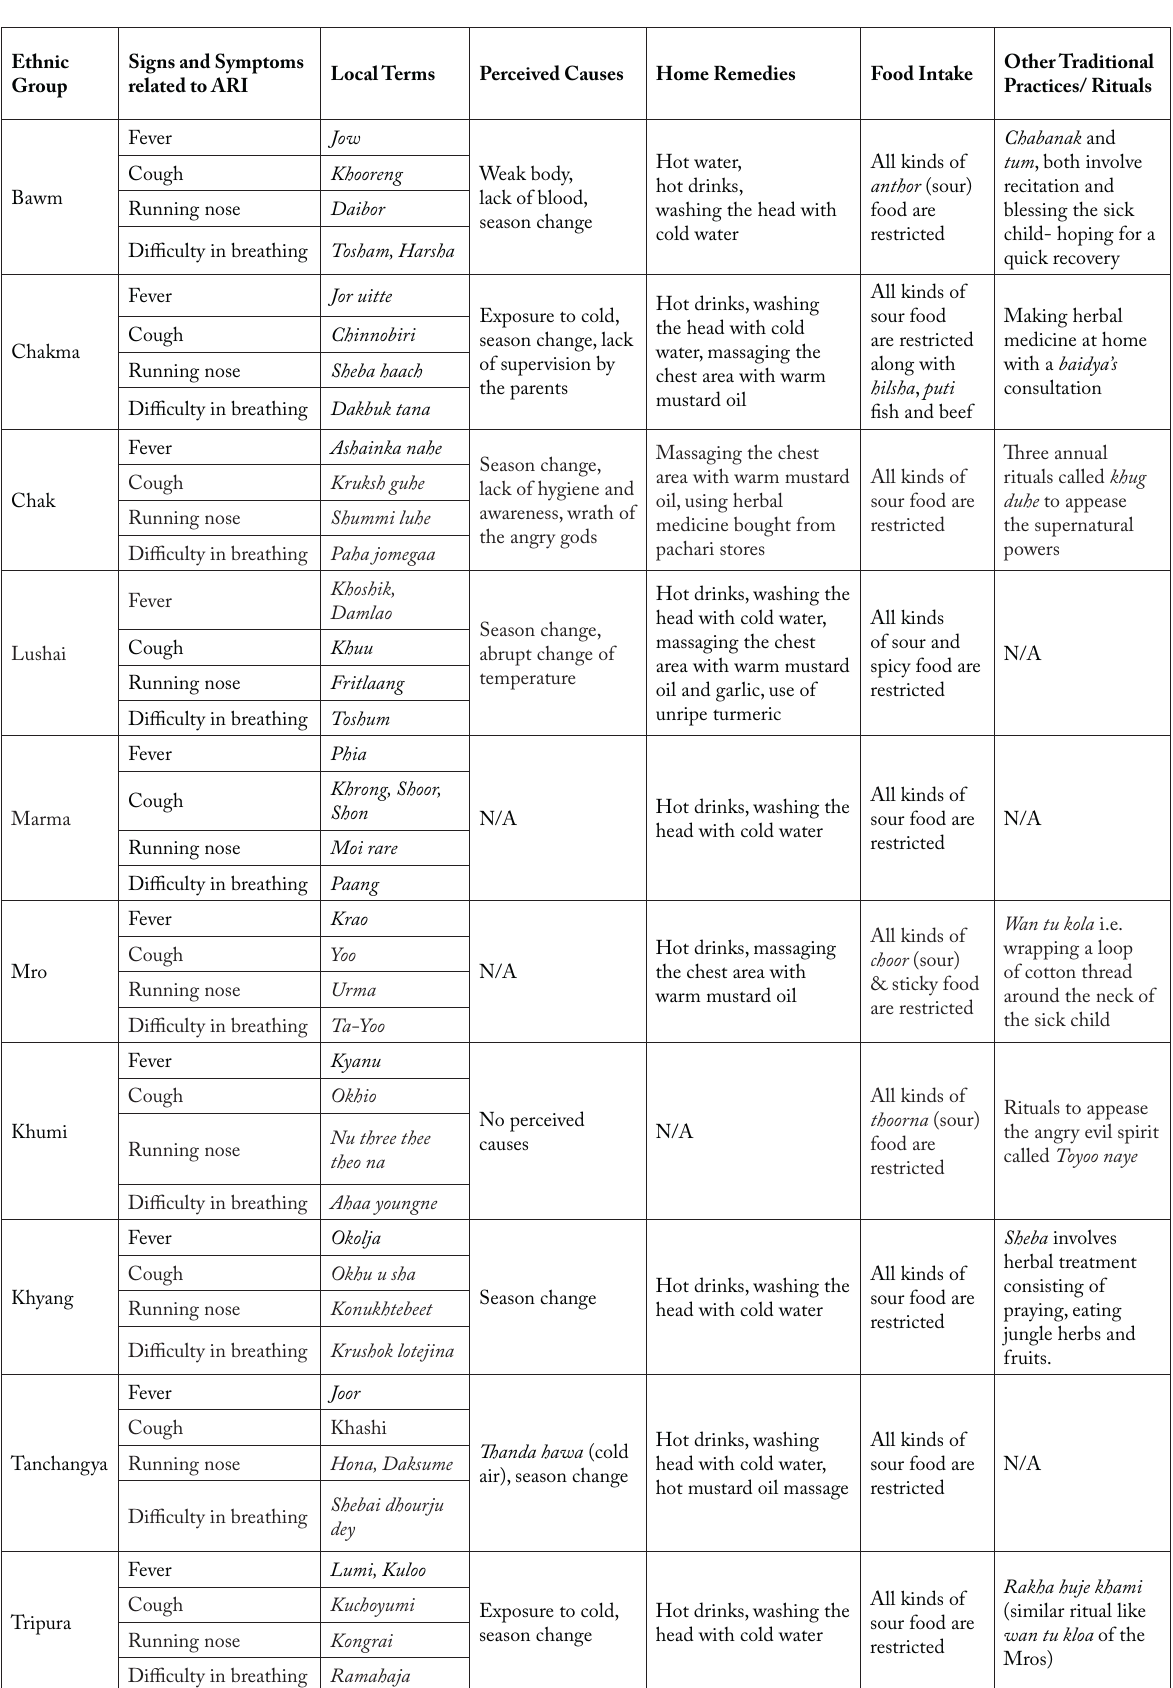
Table 1. Explanatory Models (EMs) of ARI in children in ethnic groups of CHT, Bangladesh.